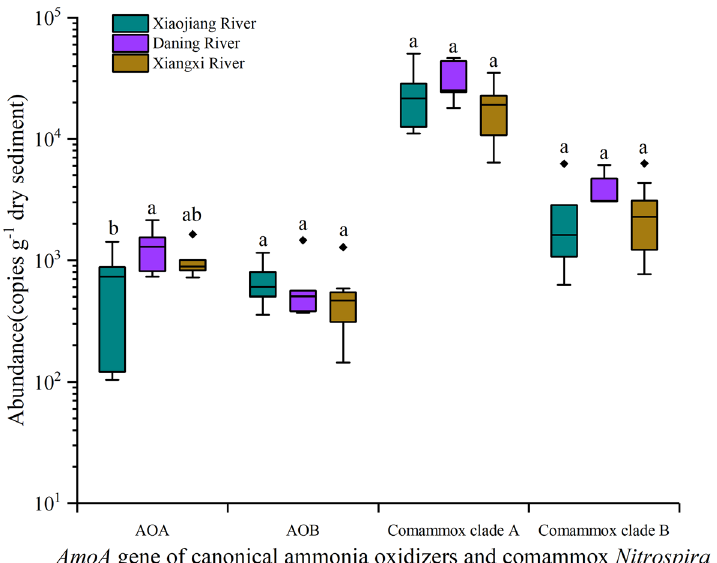
Figure 3. AmoA gene abundance of comammox Nitrospira and canonical AOMs in the sediments of sampling tributaries. Different lower-case letters indicate a significant difference among different AOMs at the level of P < 0.05 by Duncan’ test.